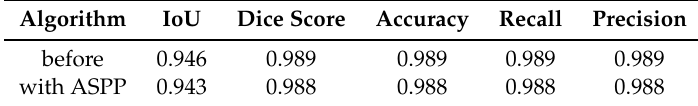
Table 4. Metrics measured before and after applying the ASPP block on FC-DenseNet103 network.